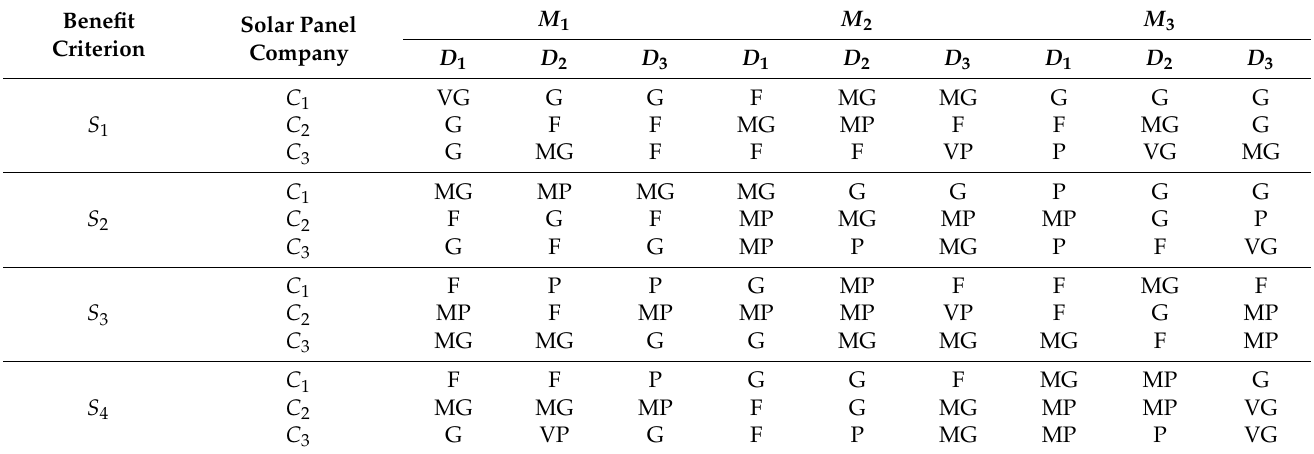
Table 7. Evaluation of each alternative by the decision-makers from M 1 , M 2 , and M 3 .